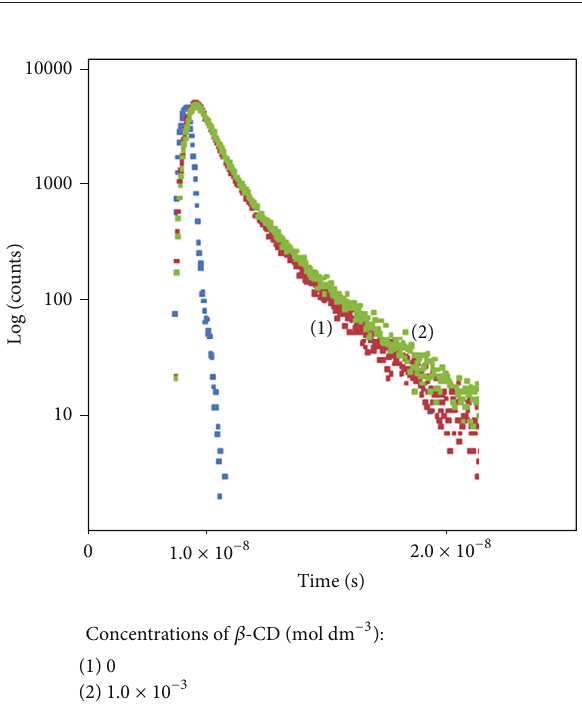
Figure 3: Time-resolved fluorescence spectra of C334 in 𝛽 -CD.